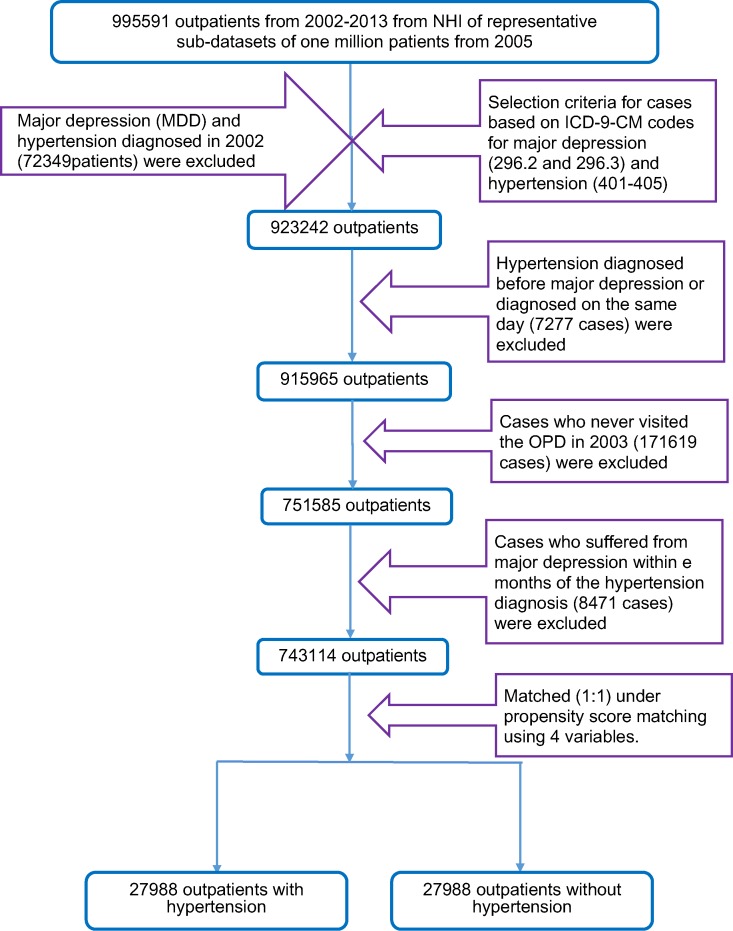
Flowchart of sample selection. Retrospective design for major depression and hypertension.